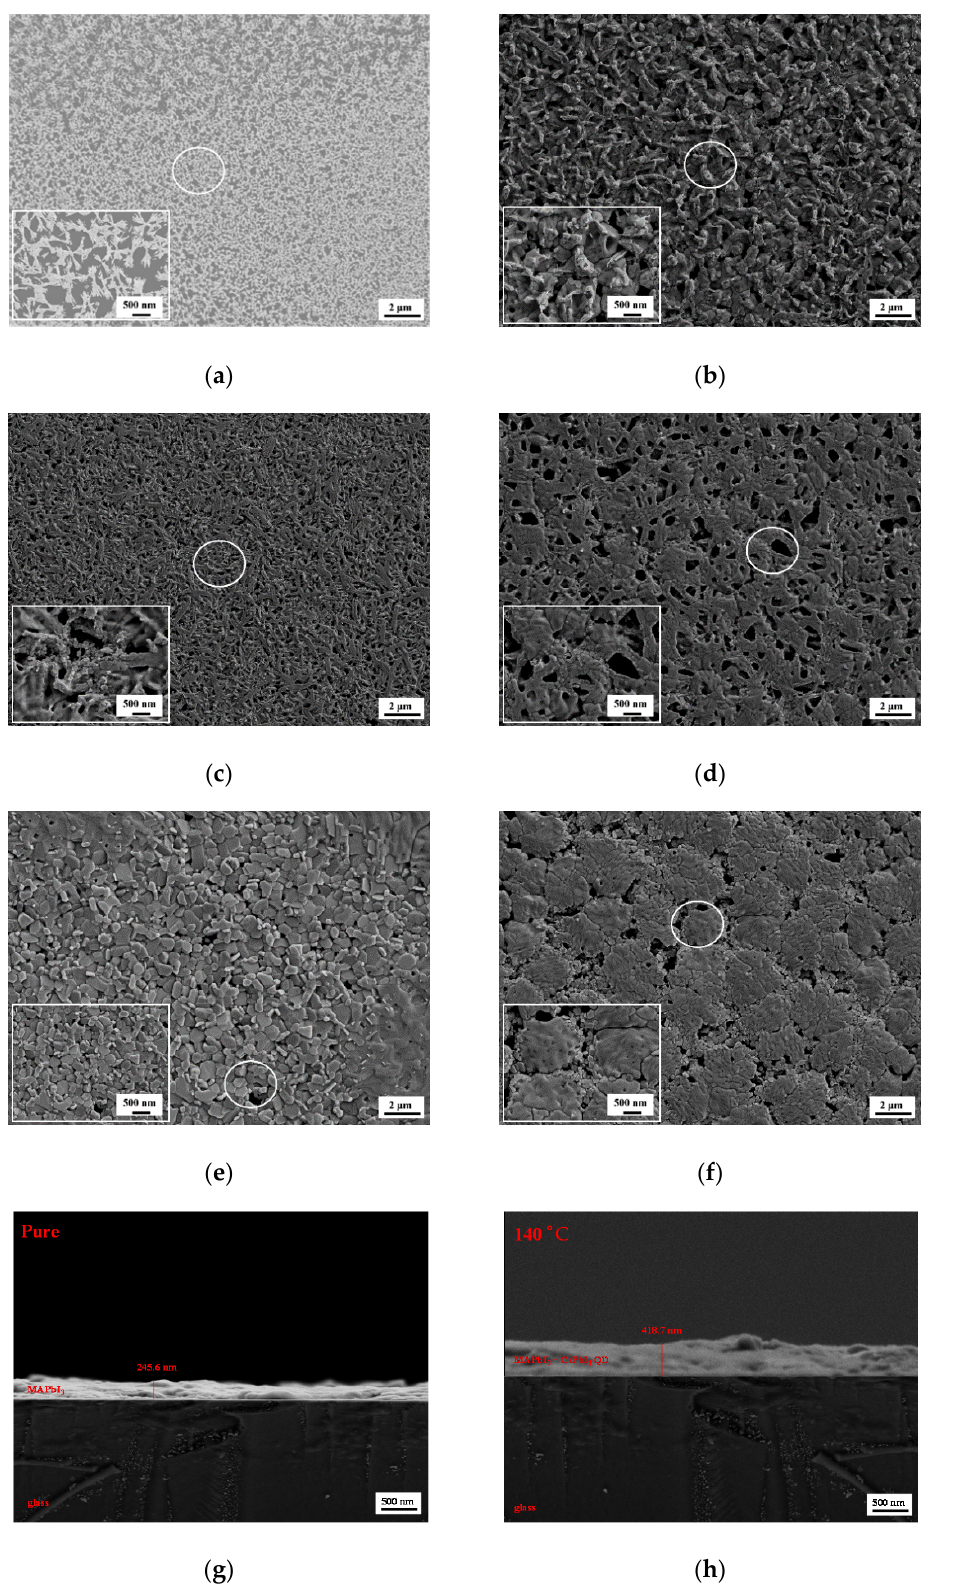
Figure 6. SEM images (top view) of ( a ) pure MAPbI 3 and ( b – f ) CsPbI 3 -QDs doped perovskite thin films at different annealing temperatures with scale size of 2 μ m and inset images are 500 nm. ( g – h ) Cross-sectional SEM images of pure MAPbI 3 and CsPbI 3 -QDs doped perovskite thin films at 140 °C.